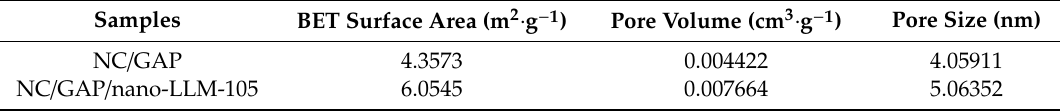
Table 2. BET surface area and the pore structure parameters of the nanofibers.